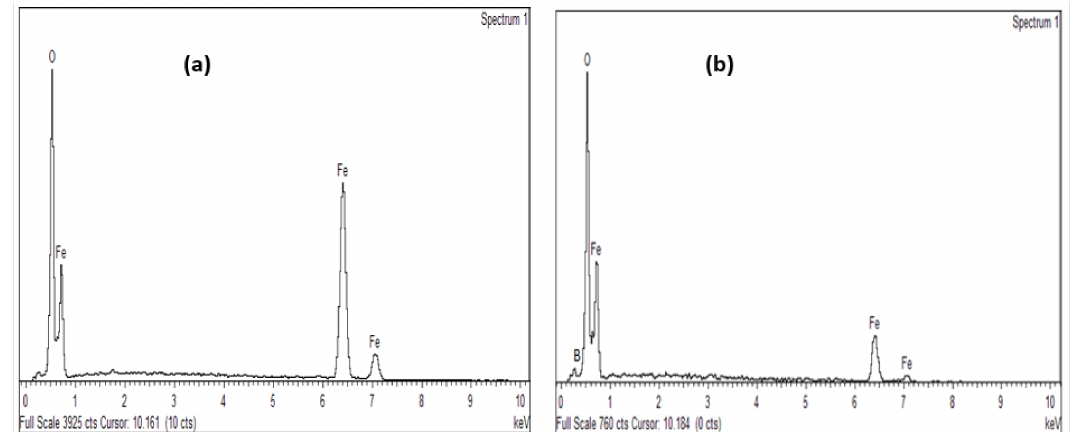
Figure 4. EDX spectra of the synthesized nano-magnetite (Fe 3 O 4 ), ( a ) before adsorption and ( b ) after